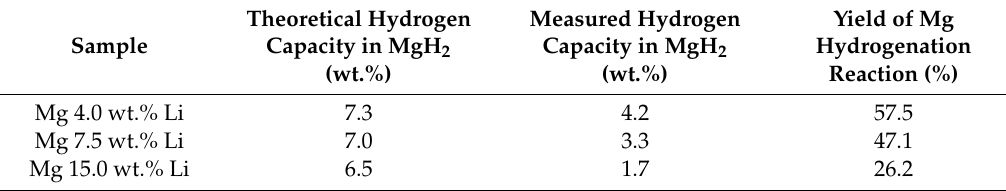
Table 2. The hydrogenation properties of alloys with various lithium contents.